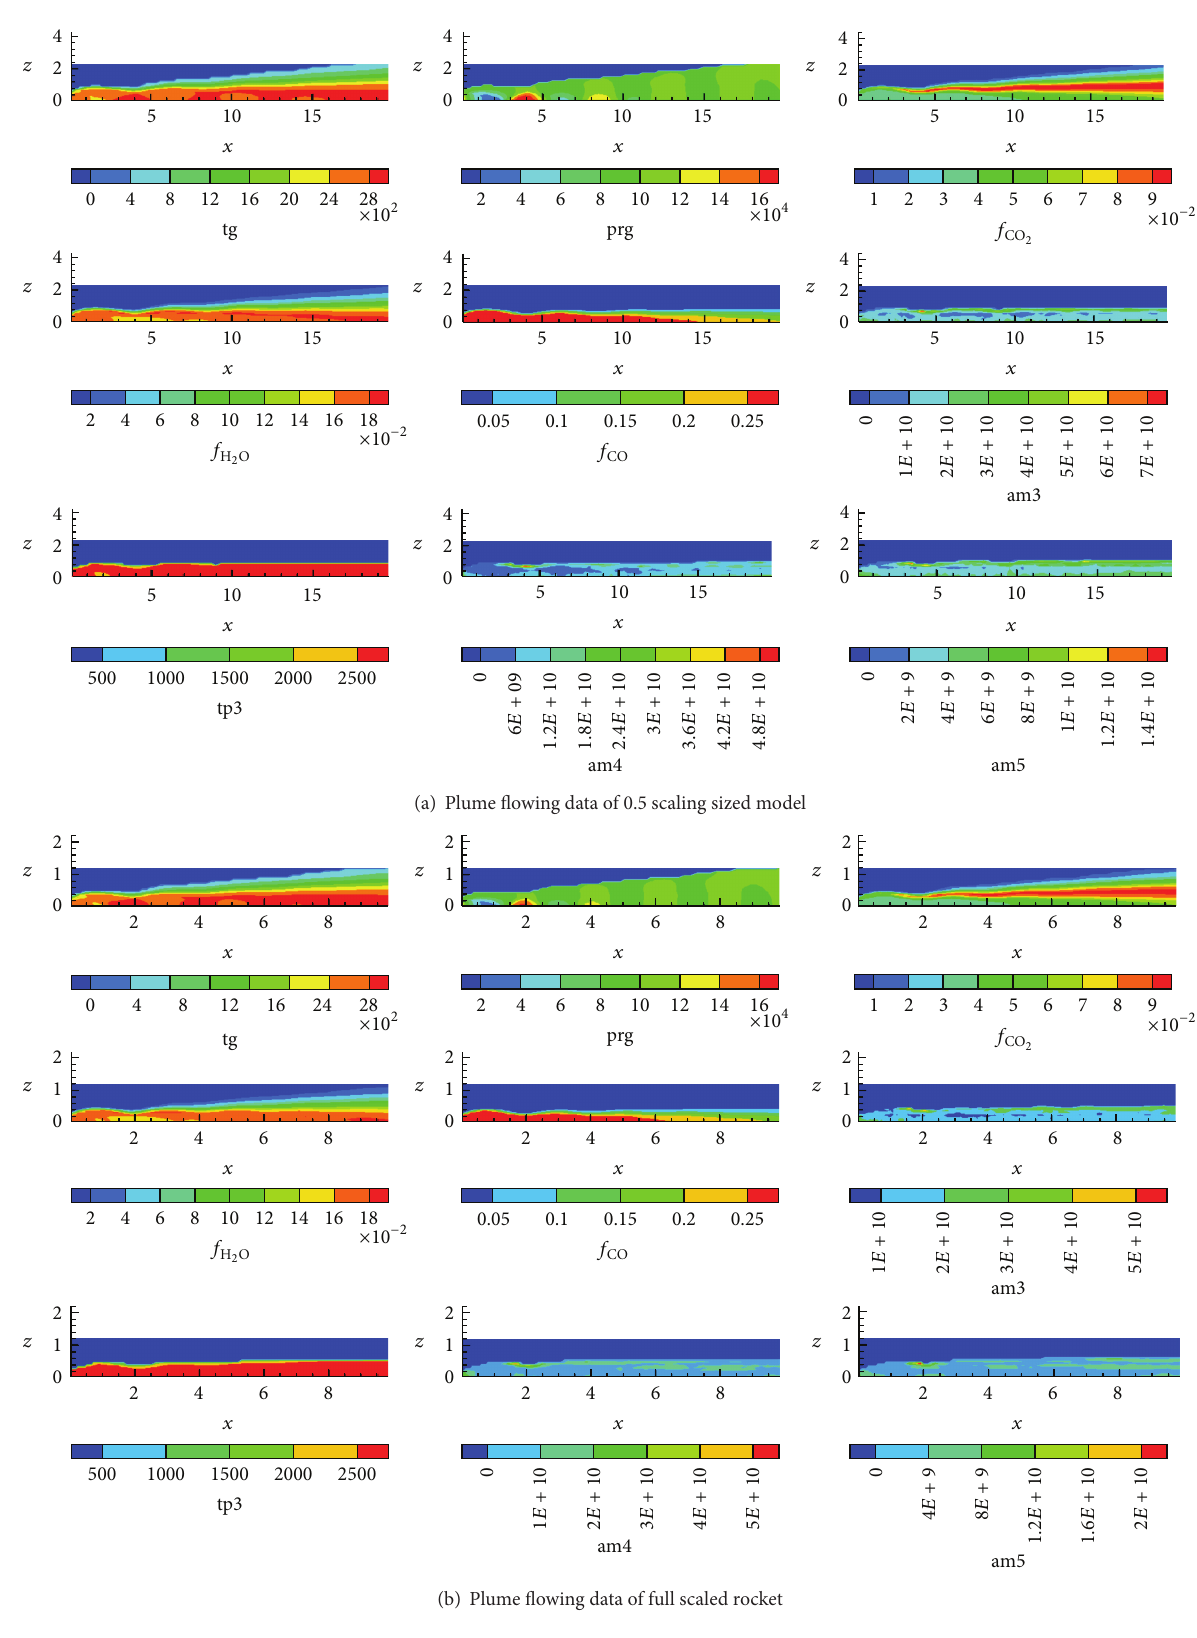
Figure 1: Plume flowing data of the 0.5 scaling model and full scaled solid